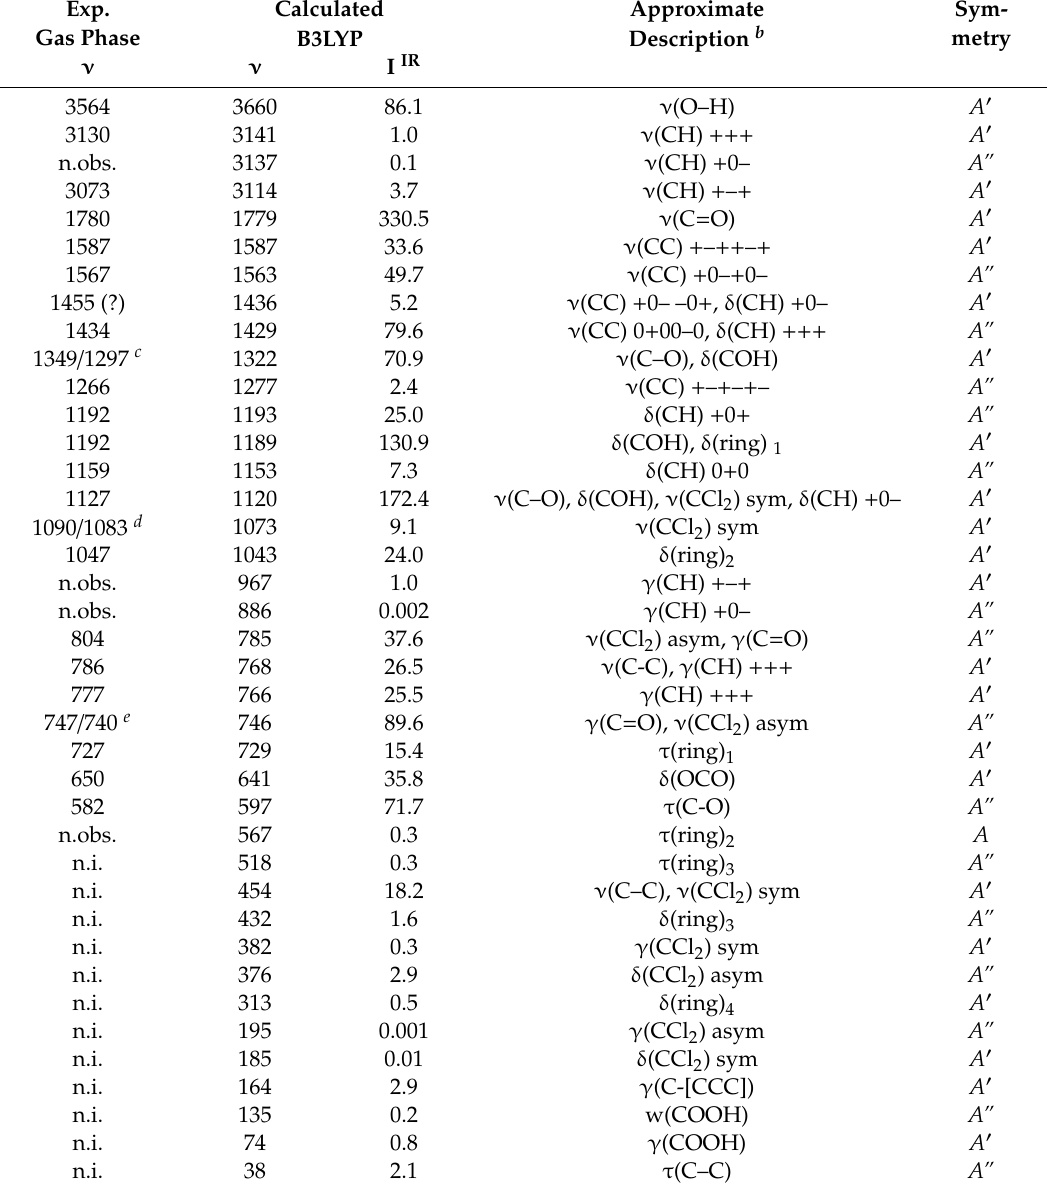
Table 7. Experimental (Exp.) and B3LYP / 6-311 ++ G(d,p) calculated (Calc.) infrared spectra of monomeric 2,6-dichlorobenzoic acid, and band assignments a .